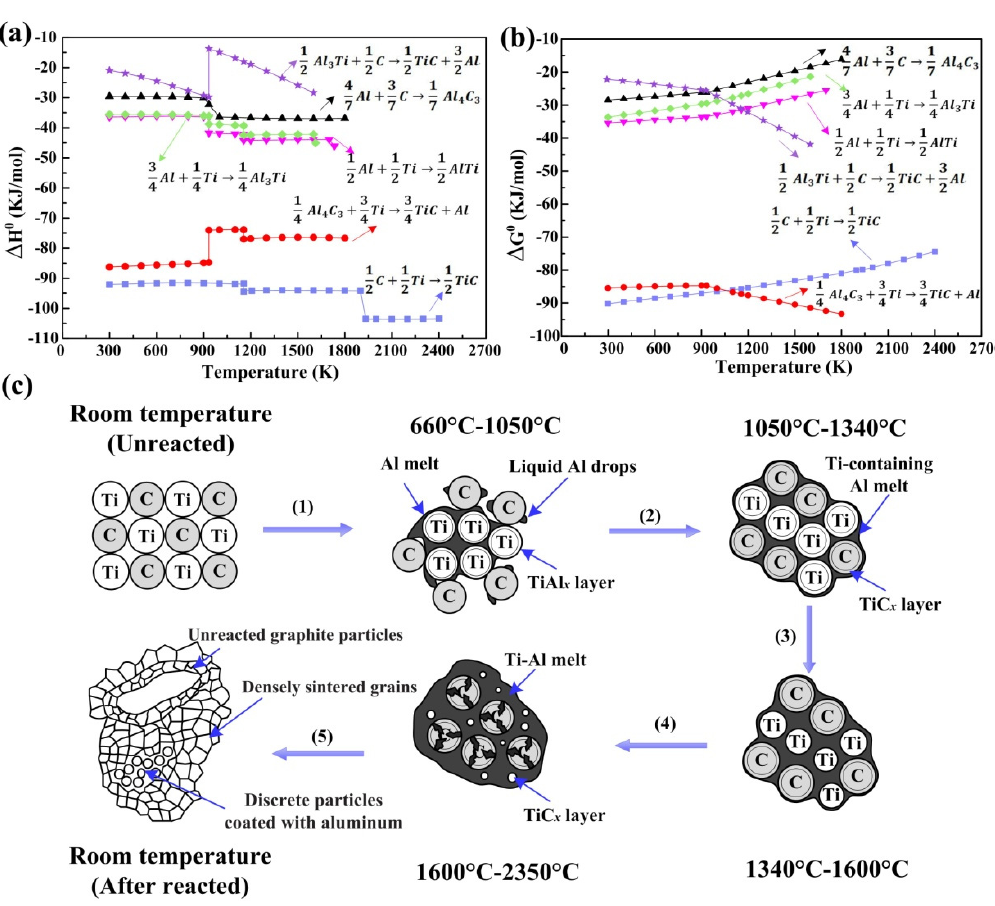
Figure 9. Changes in ( a ) reaction enthalpy, ∆ H and ( b ) Gibbs free energy, ∆ G in Ti-Al-C system; ( c ) Proposed mechanism of ignition and reaction of the Ti-Al-C system according to Lee et al.